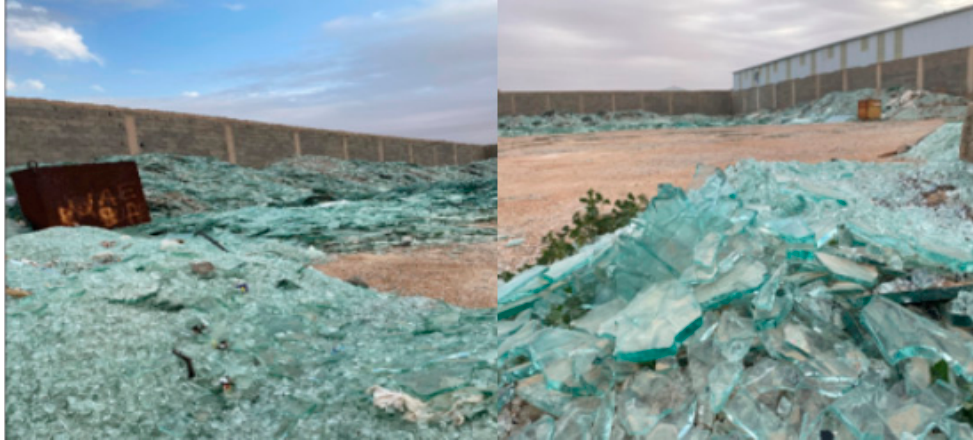
Figure 1. Glass waste at dumpsite in Hafr Al-Batin.